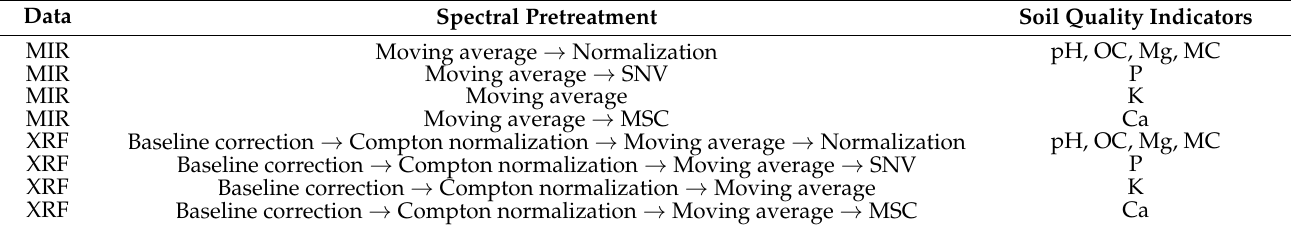
Table 3. Best preprocessing steps considered for correction of mid infrared (MIR) and X-ray fluores- cence (XRF) spectral